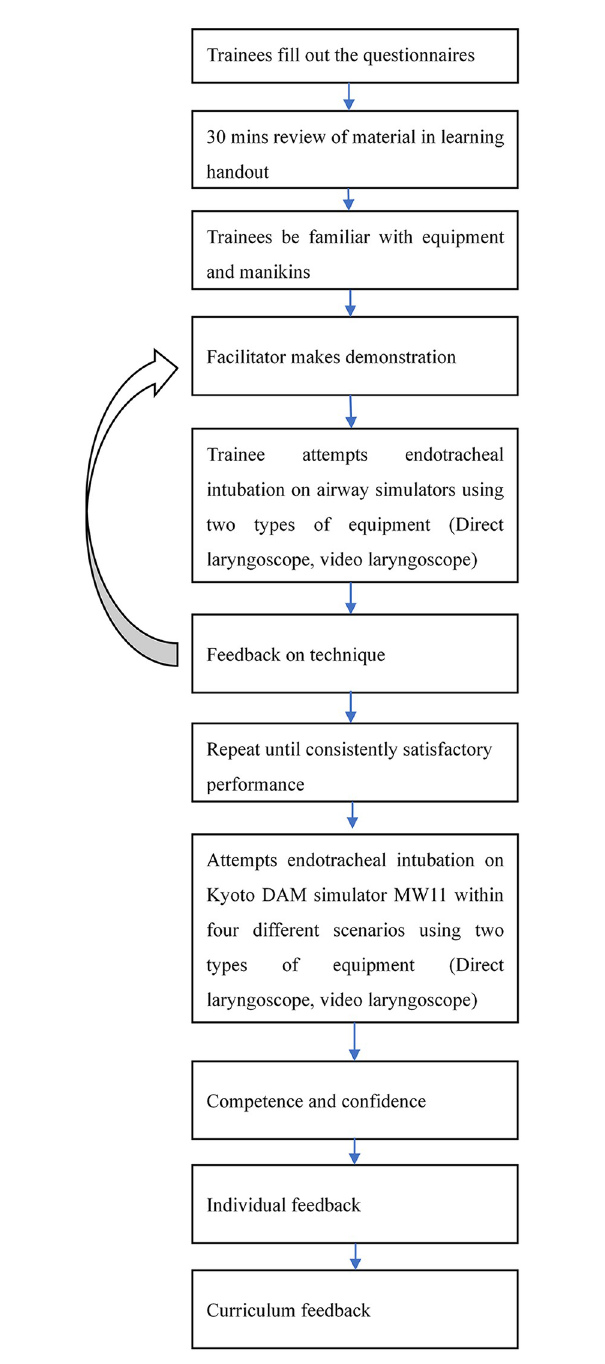
Fig 1. Flowchart of steps in teaching and learning endotracheal